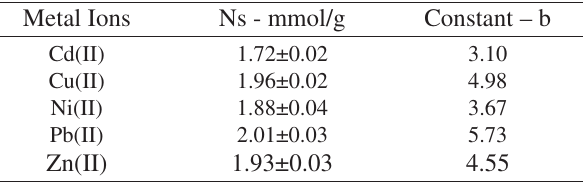
Table 1. A dsorption per gram of Cell-PAB surface (Ns) for metal ions in aqueous medium.